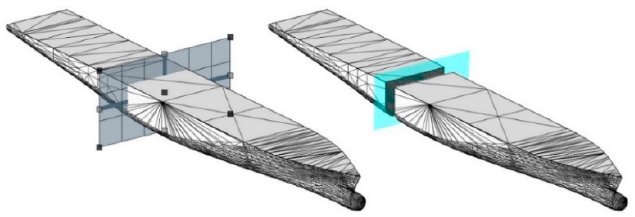
Figure 6. Cutting plane and hull stereolithographic model.